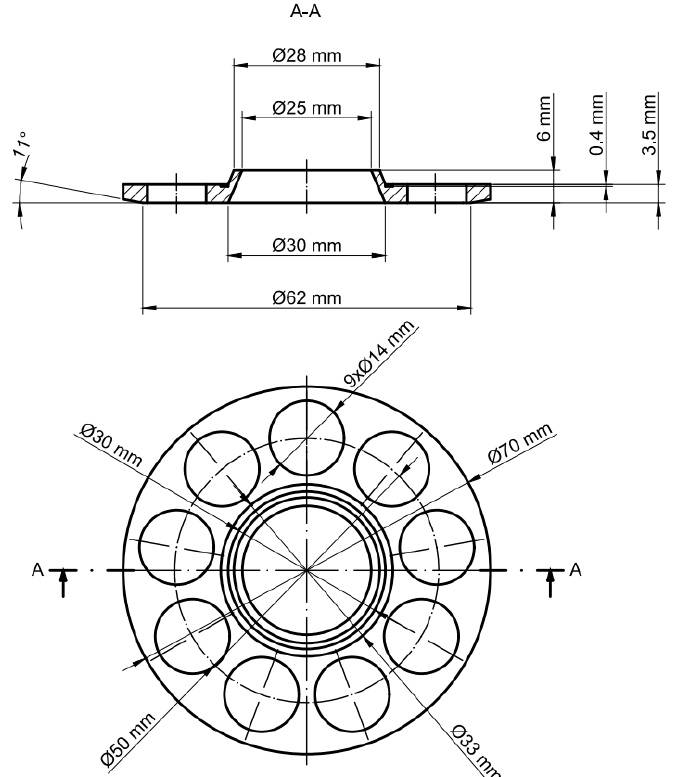
Figure 2. The slipper-retainer drawing with dimensioning. Table 1. Parameters used for samples manufacturing.